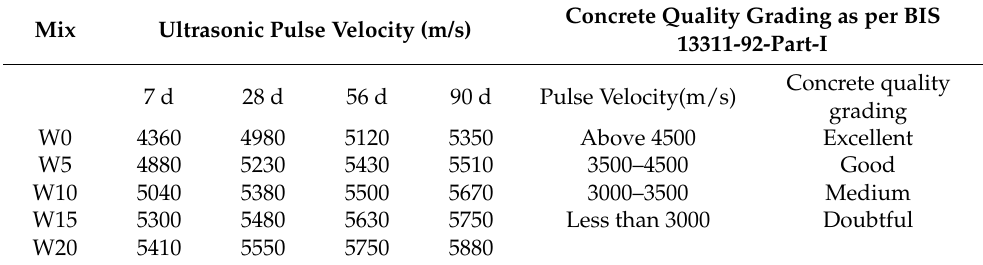
Table 5. UPV of the WSA concrete and the concrete quality grading specified in BIS.